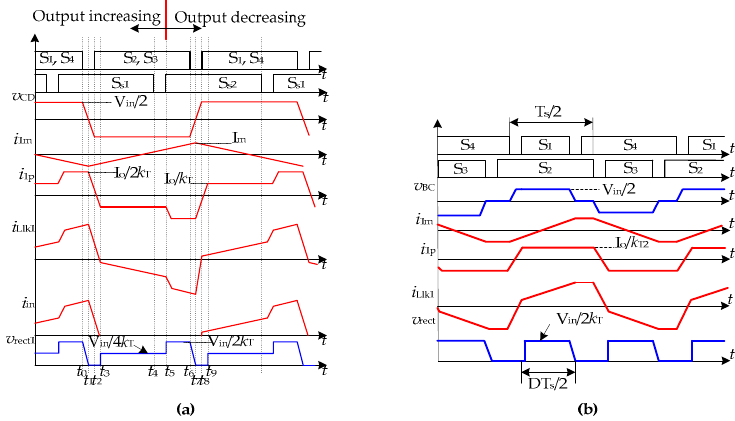
Figure 6. Key waveforms: ( a ) secondary modulation; ( b ) primary modulation.